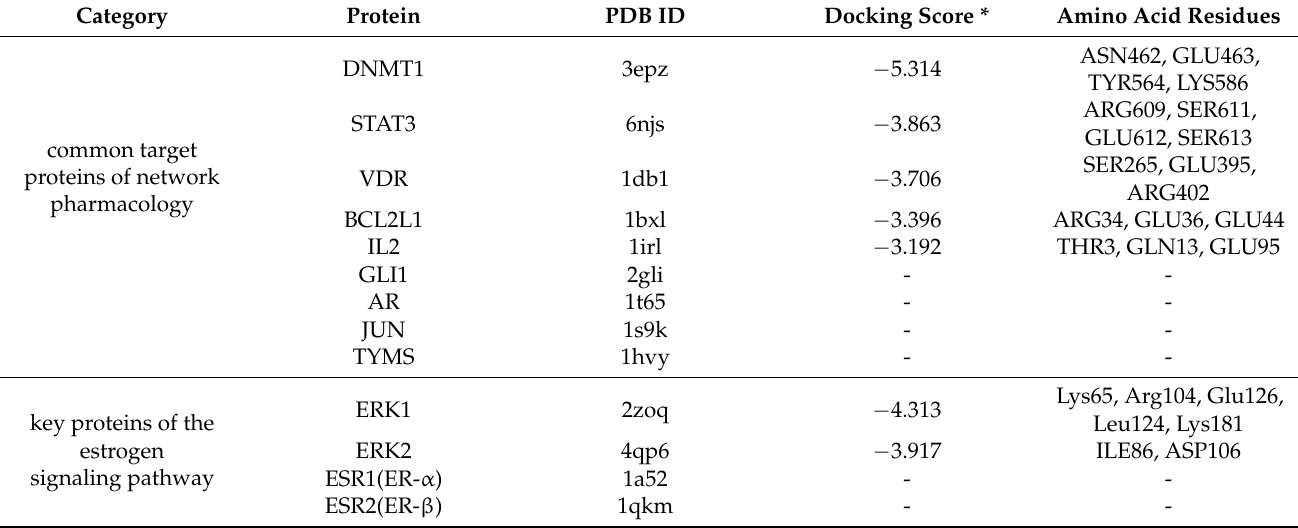
Table 2. The docking score table of molecular docking for SsI and proteins.